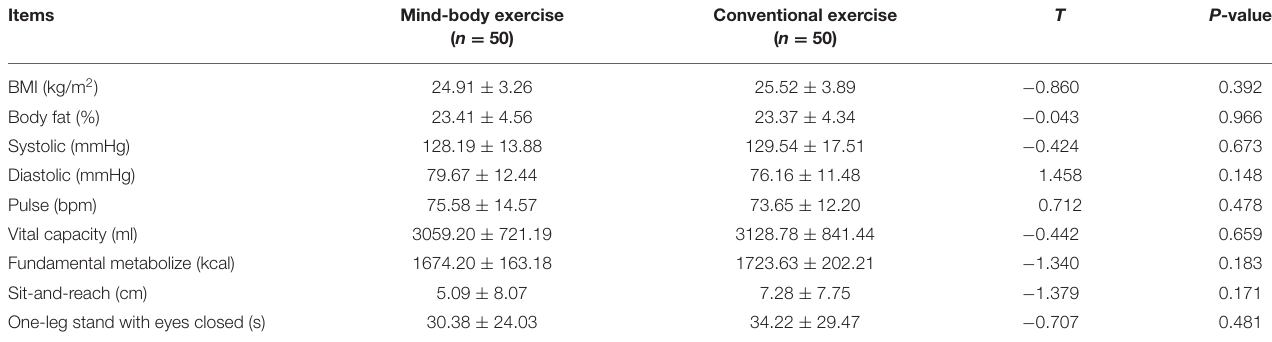
TABLE 2 | Physiological and physical fitness outcome comparison between the MBE and CE groups at the baseline. Items